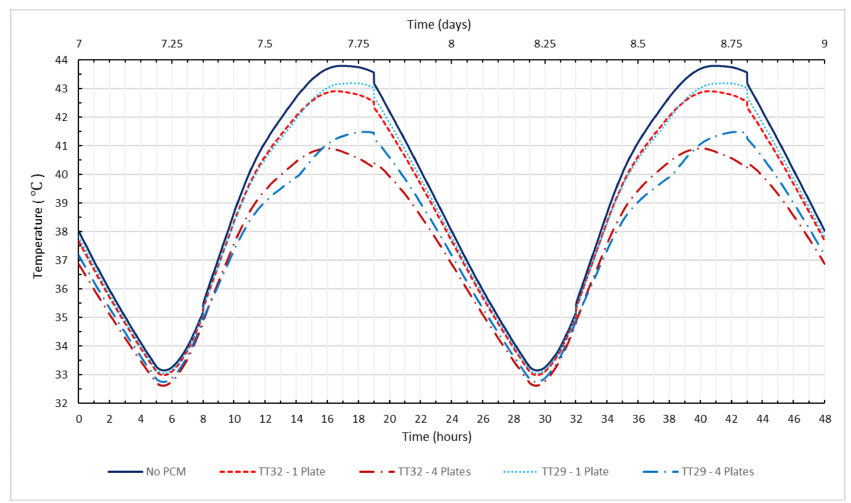
Figure 13. Indoor temperatures, for the low inertia case with natural convection at the place surfaces, under heat wave conditions.